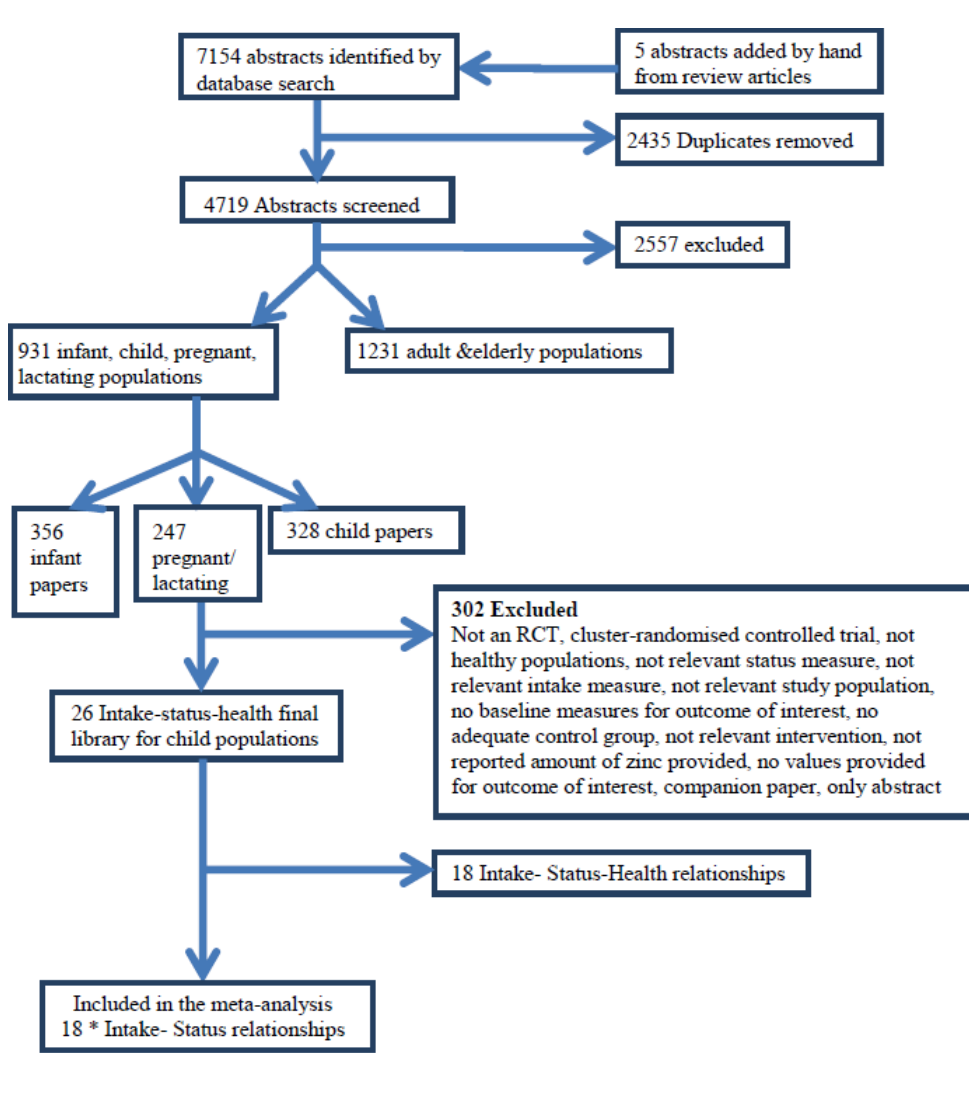
Figure 1. Study selection process for systematic review (* some papers reported more than one